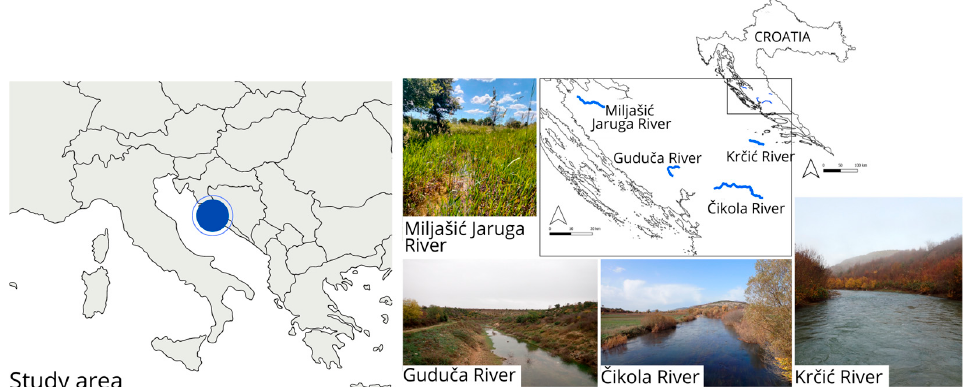
Figure 1. Map showing the position of the study area in the karst Mediterranean region of the Balkans, with locations of the studied intermittent rivers in Croatia. Examples of the study sites at each river are shown in the photographs.